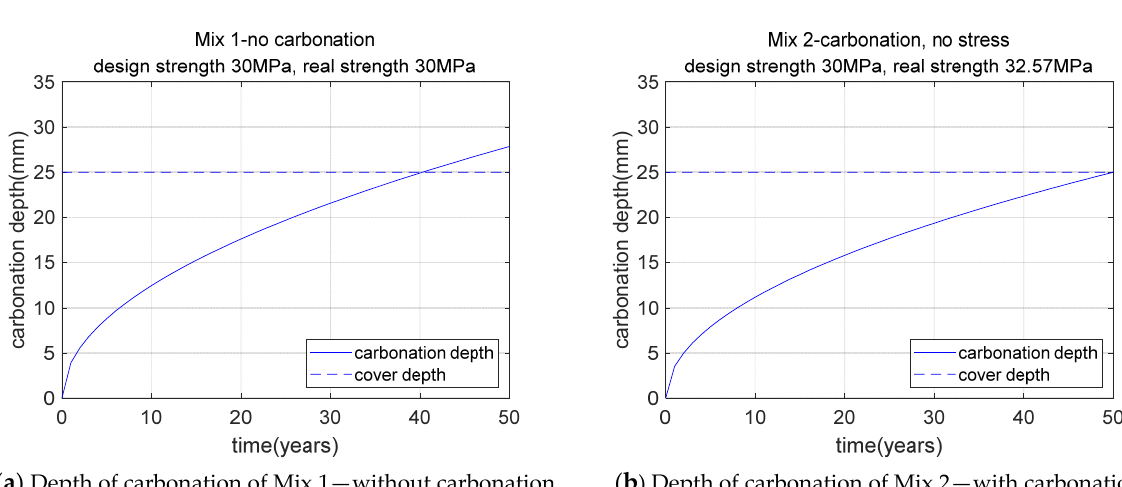
Figure 3. Depth of carbonation of case study 1 (free of stress): Mix 1 and Mix 2. Table 5. Optimization mixtures of case studies (kg/m 3 ).